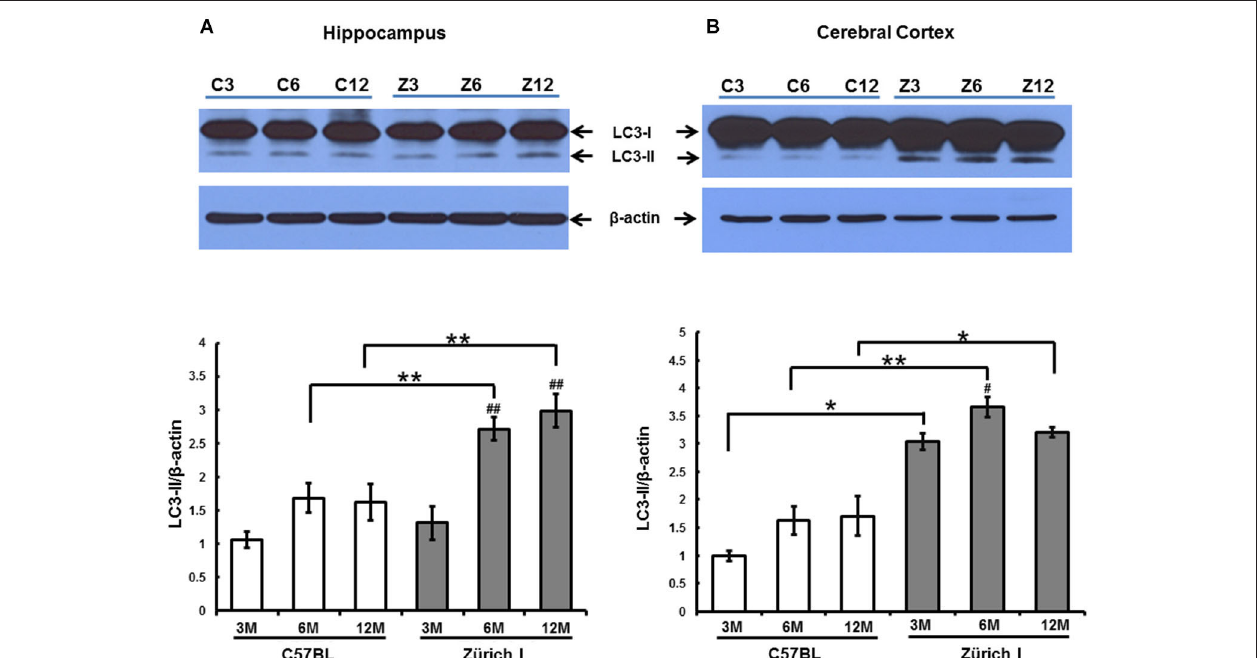
(B) The level of LC3-II in the cerebral cortex of Zürich I mice was significantly higher than for C57BL/6J mice (* p < 0.01, ** p < 0.001). The level of LC3-II in the cortex of Zürich I mice was significantly increased at 6 months of age compared to 3 months of age ( # p < 0.01). Thirty-six mice (2 separate experiments of WT and Zürich I mice age groups: 3 months, n = 3; 6 months, n = 3; 12 months, n = 3) were used. These results are representative of at least two separate